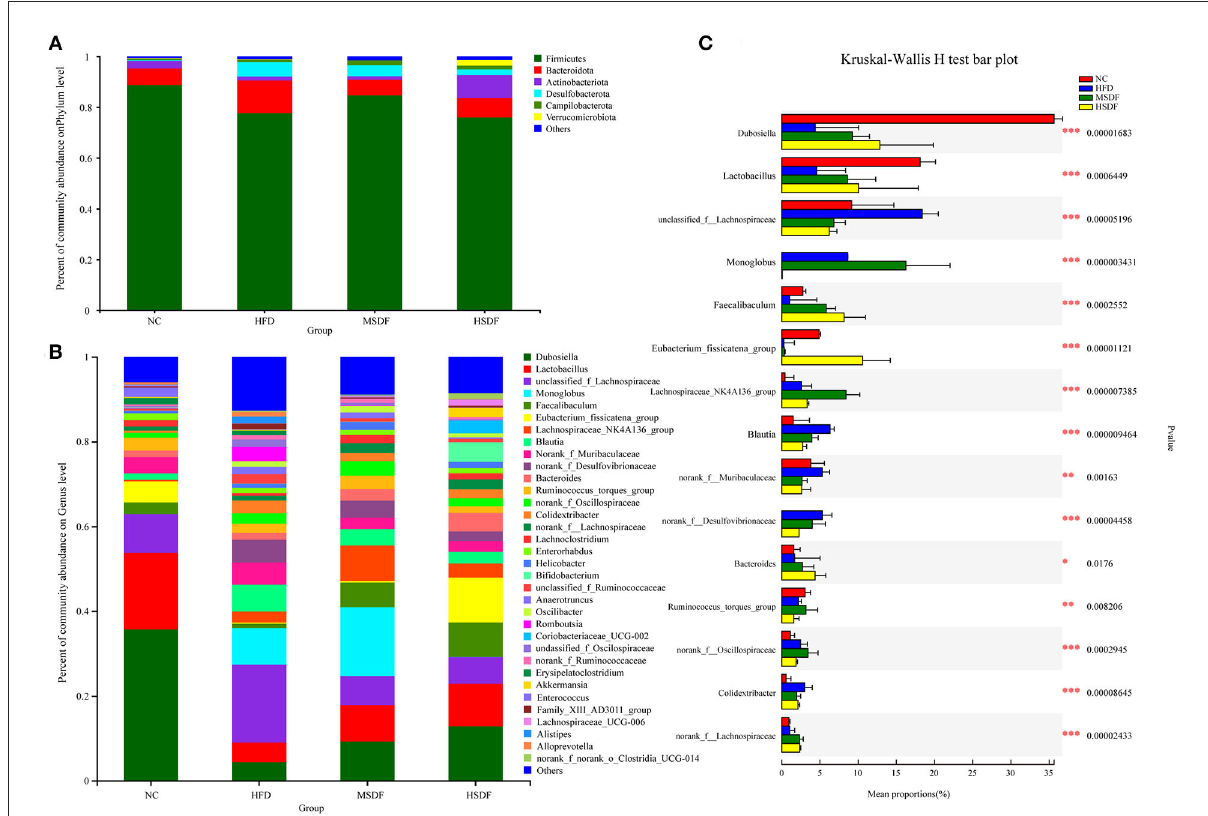
FIGURE2 Effect of PP-SDF administration on the composition of the gut microbiota in phylum and genus levels. (A) At the 12-week phylum level. (B) At the 12-week genus level. (C) The difference between groups was tested at the genus level. Values were presented as mean ± SD ( n = 8). The variability between groups was represented by